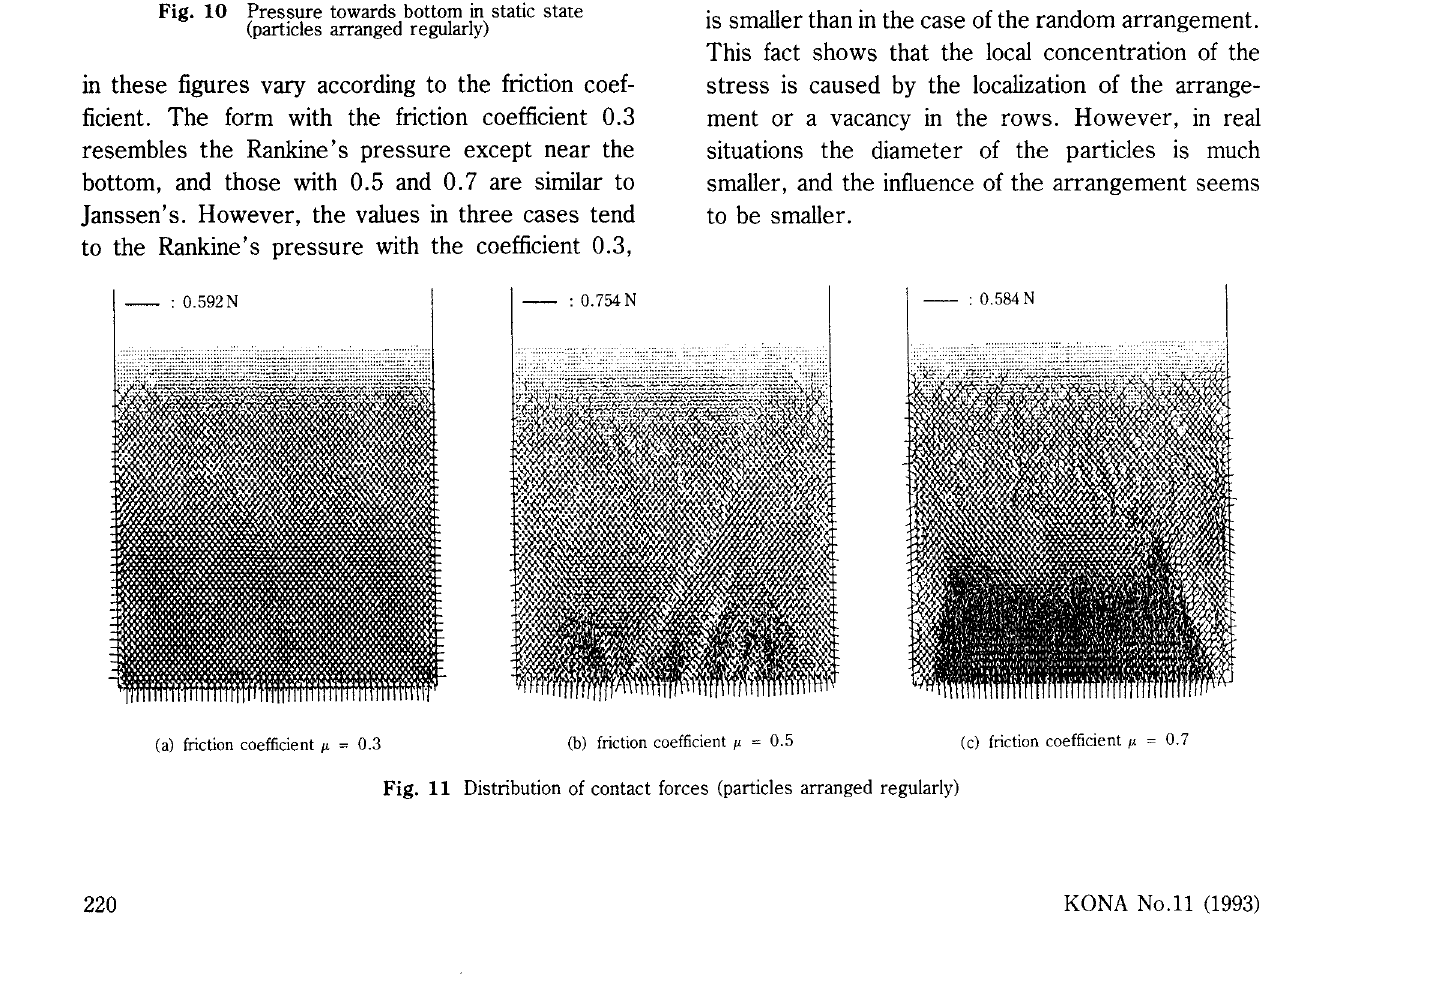
Fig. 10 Pressure towards bottom in static state (particles arranged regularly)